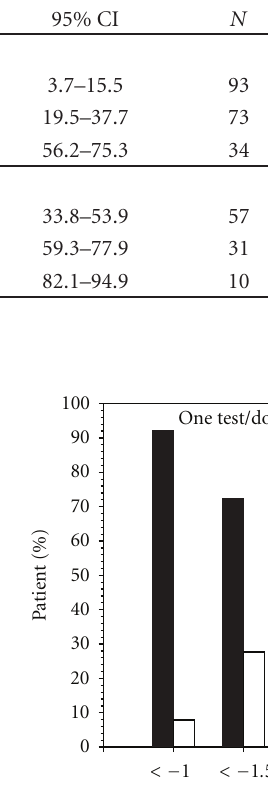
Figure 1: Distribution of both Parkinson’s disease patients with mild cognitive impairment (PD-MCI, black bars) and without (PD- noMCI, white bars) by use of varying diagnostic criteria. Cognitive impairment was chosen to be present in less than 16% ( z < − 1), 7% ( z < − 1 . 5) (PR < 7), or 2% ( z < − 2) of healthy controls in at least one or two tests per cognitive domain. This demonstrates that the frequency of PD-MCI was highly influenced by the selection of the cut-o ff